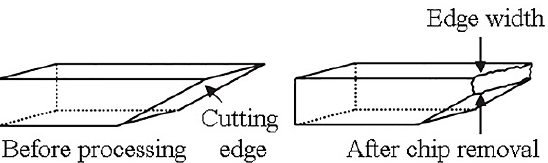
Figure 9. Diagram of the wear of the cutting edge showing the formation of a nose with a wider width than the original tool [84].